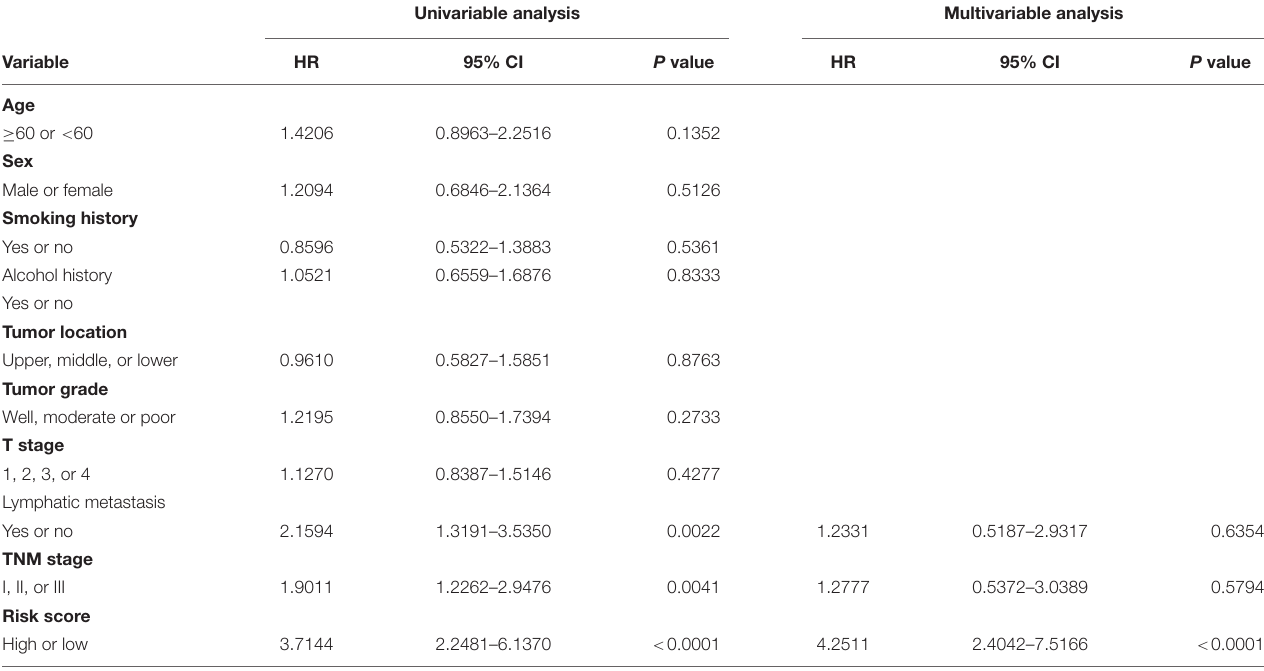
TABLE 1 | Univariable and multivariable Cox regression analysis of the six-gene immune-related signature and overall survival in GSE53624 cohort. Univariable analysis Multivariable